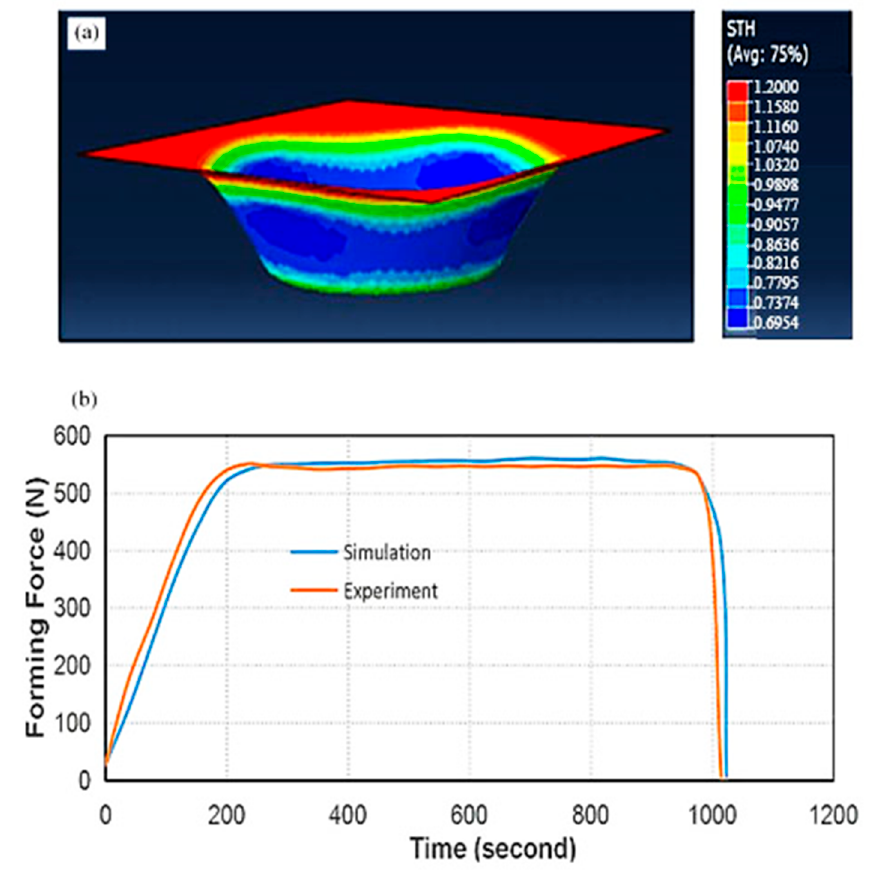
Figure 3. ( a ) The formed part thickness distribution, and ( b ) the forming force plot from the present simulation and the experimental results from the literature. The experimental graph was reused with permission from [19]. Elsevier.